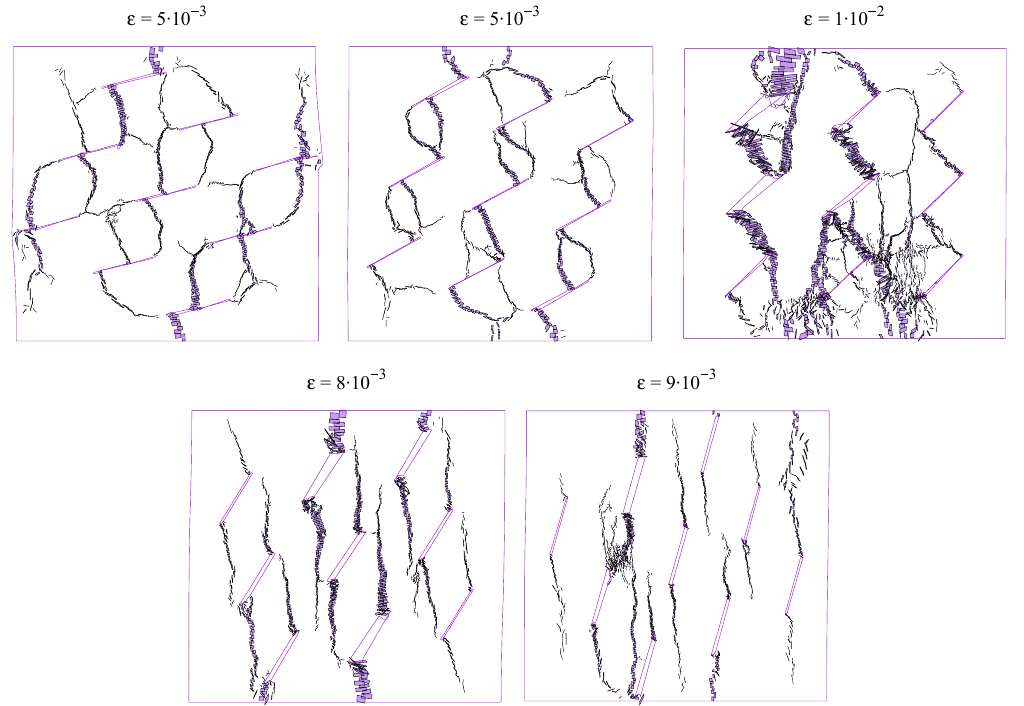
Figure 18. Rock-like materials with nine parallel fissures: the numerically obtained crack opening plots (deformation scale